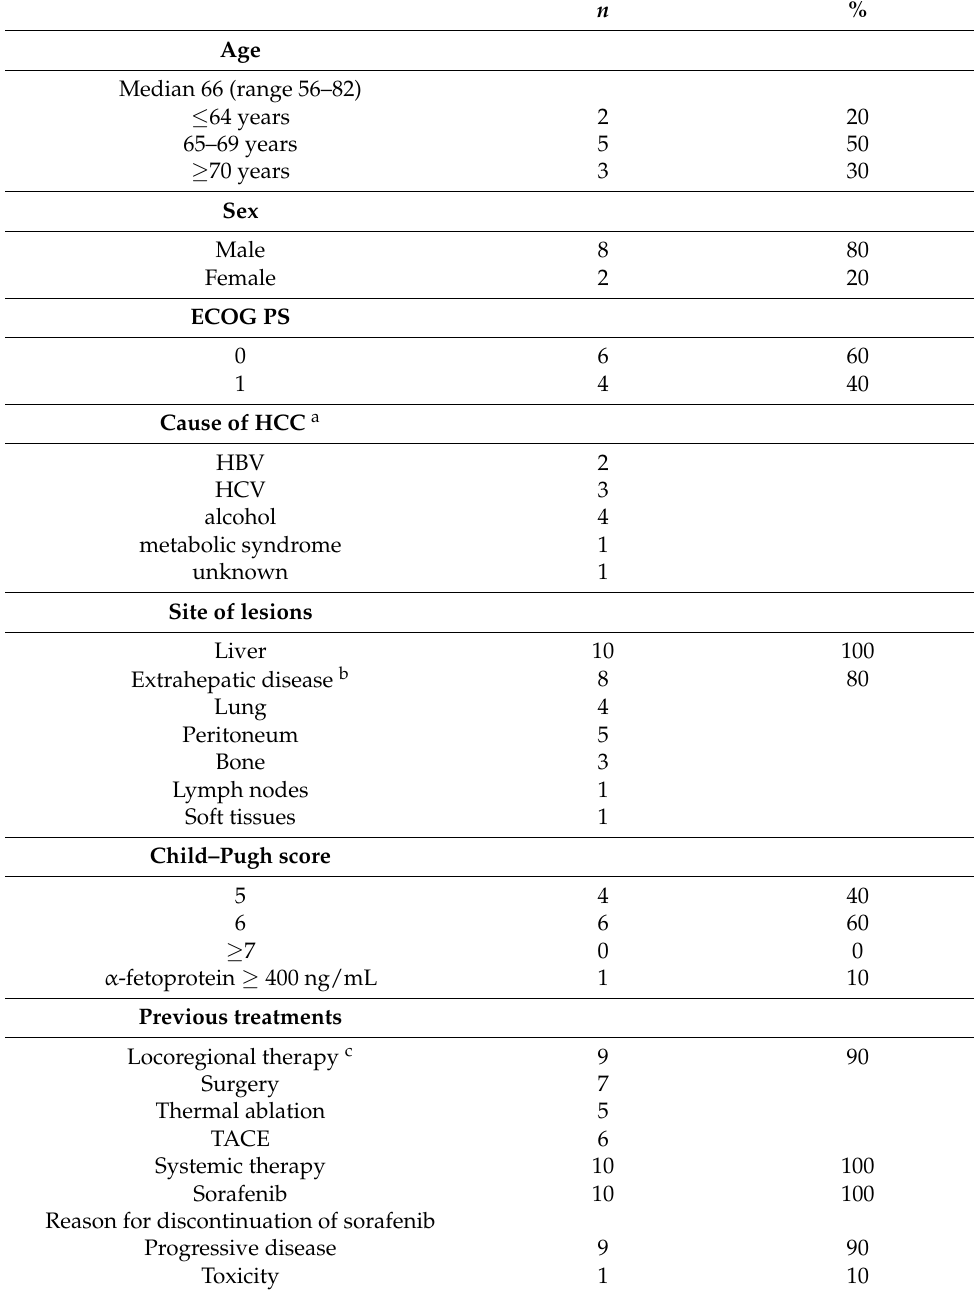
Table 1. Patient baseline